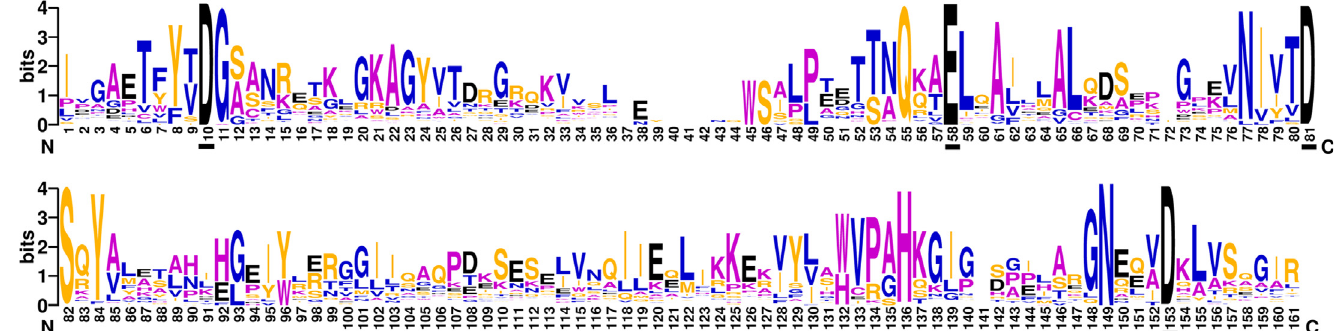
Fig 3. RNH motif plotted by weblogo software. The overall height of the stack indicates the sequence conservation at each position, the height of symbols within the stack represents the relative frequency of amino acid at that position, while the four underlined residues (D10, E58, D81 and D153) display the DEDD motif in RNH